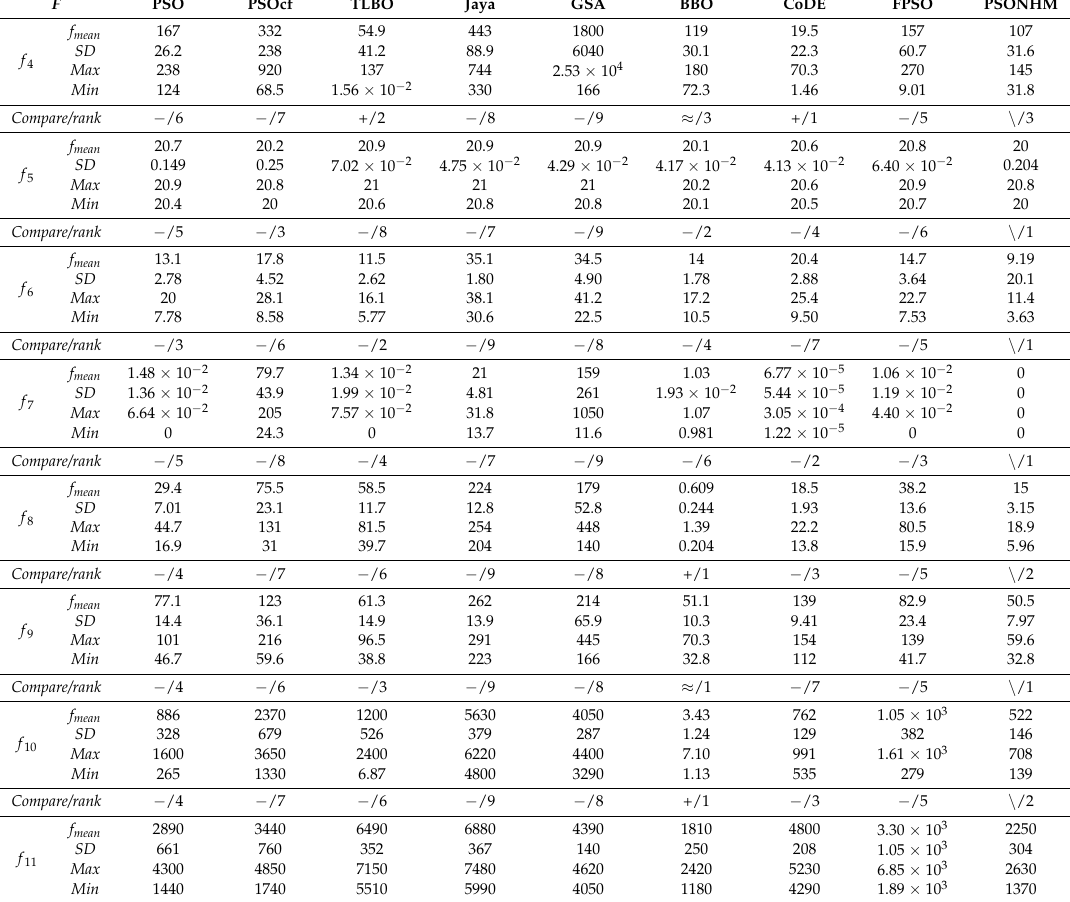
Table 3. Experimental results of PSO, PSOcf, TLBO, Jaya, GSA, BBO, CoDE, FPSO and PSONHM on f 4 – f 16